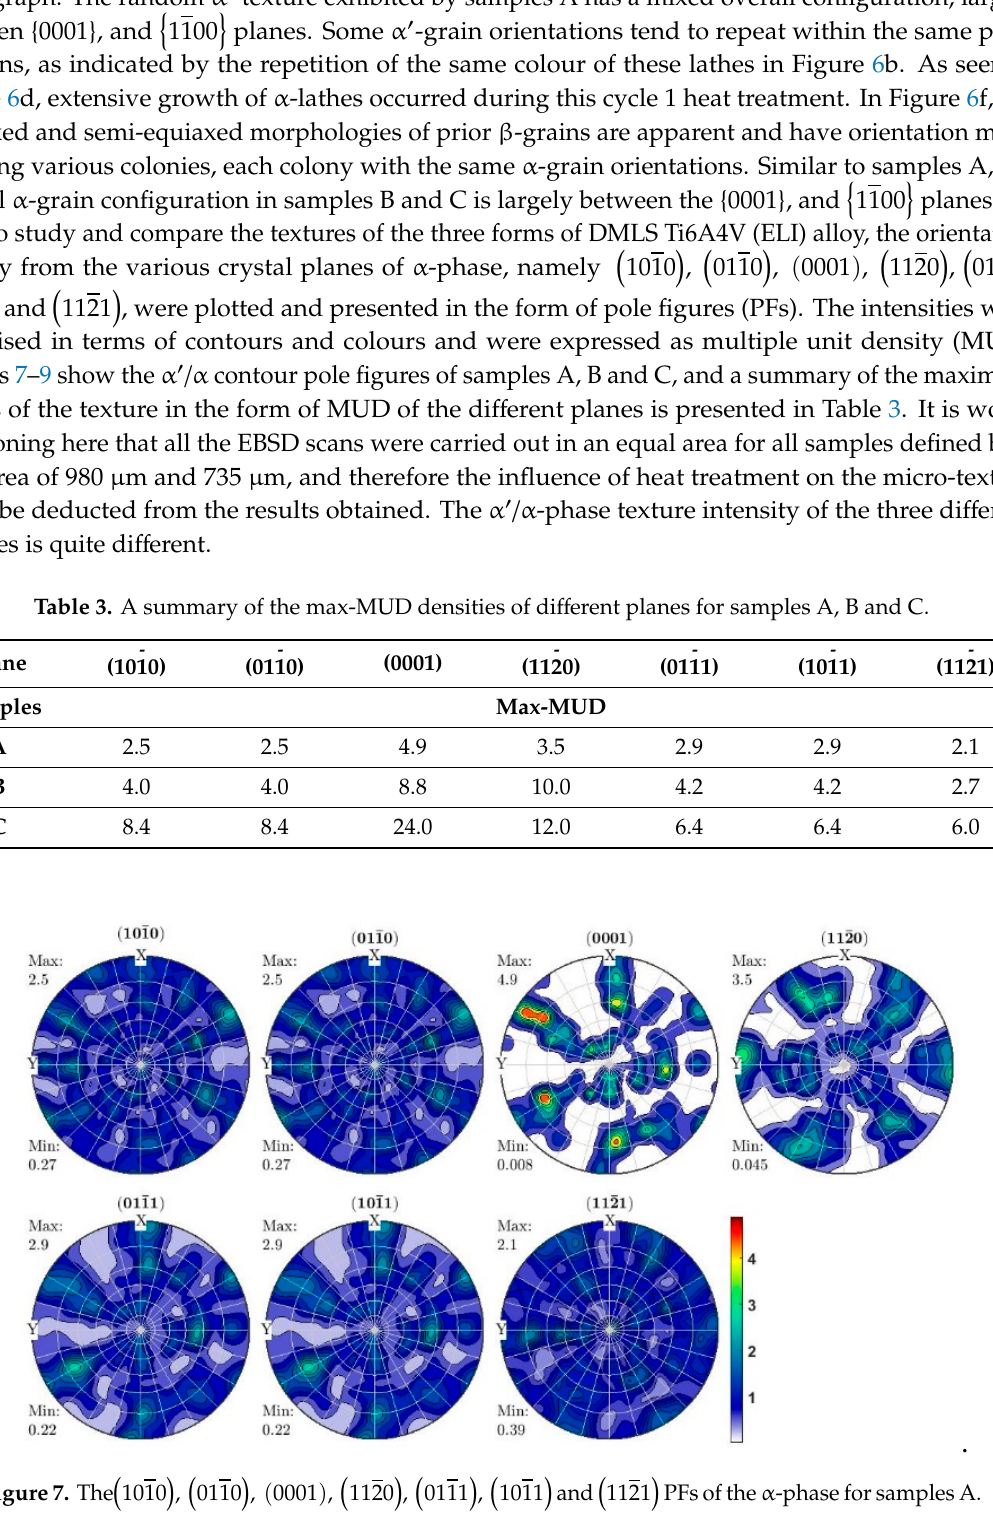
Figure 7. The Figure 7. The (101(cid:3364)0), (011(cid:3364)0), (0001), (112(cid:3364)0), (011(cid:3364)1), (101(cid:3364)1) and (112(cid:3364)1) PFs of the α -phase for samples A.